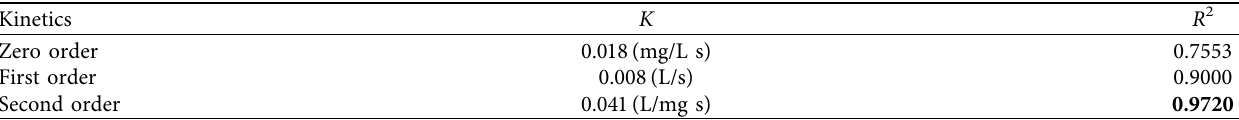
Figure 8: Effect of catalyst dose on ozone decomposition (TMP � 0.5mg/L); • : consumed ozone, ◆ : residual ozone, and ▲ : outlet ozone. Table 1: Summary of the kinetic analysis results of TMP removal for O 3 /ZnO process.